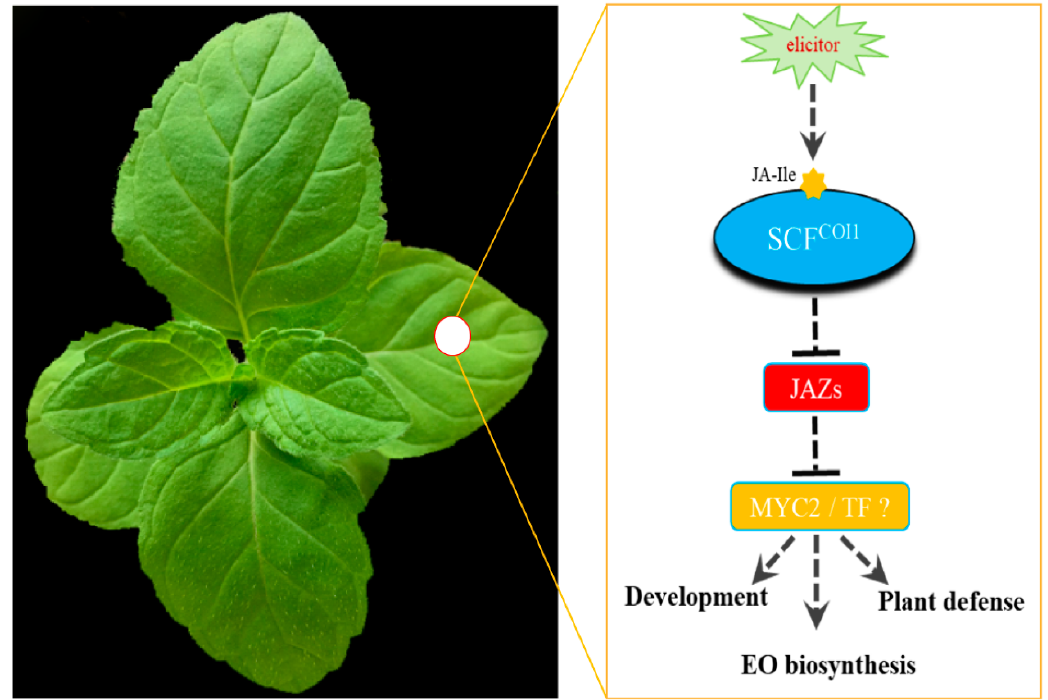
Figure 10. A proposed working model of how JA signaling module regulates diverse biological processes in response to JA signaling in M. canadensis . A simple model showing the putative role of the JA signaling module in controlling diverse biological processes in M. canadensis . McCOI1, a homolog of the Arabidopsis F-box protein CORONATINE INSENSITIVE 1 (AtCOI1) (Xie et al., 1998), acts as a putative receptor for the active molecule JA-isoleucine (JA-Ile). Introduction of the exogenous elicitor induces the production of JA-Ile, which is perceived by McCOI1 to form the activated McCOI1-JA-Ile complex that subsequently interacts with the repressor, JASMONATE ZIM DOMAIN (JAZ) proteins, and represses its transcriptional inhibitory ability by degradation of McJAZ proteins through the SCF COI1 -dependent 26S proteasome pathway (Chini et al., 2007; Howe et al., 2018). Next, degradation of the McJAZ proteins relieves repression of downstream transcription factors (TFs) including unidentified McMYC2 or other McTFs, which are involved in regulating plant development, plant defense, and essential oil (EO) biosynthesis in M. canadensis . A photograph of normal growing M. canadensis was used as the model; shown at left.